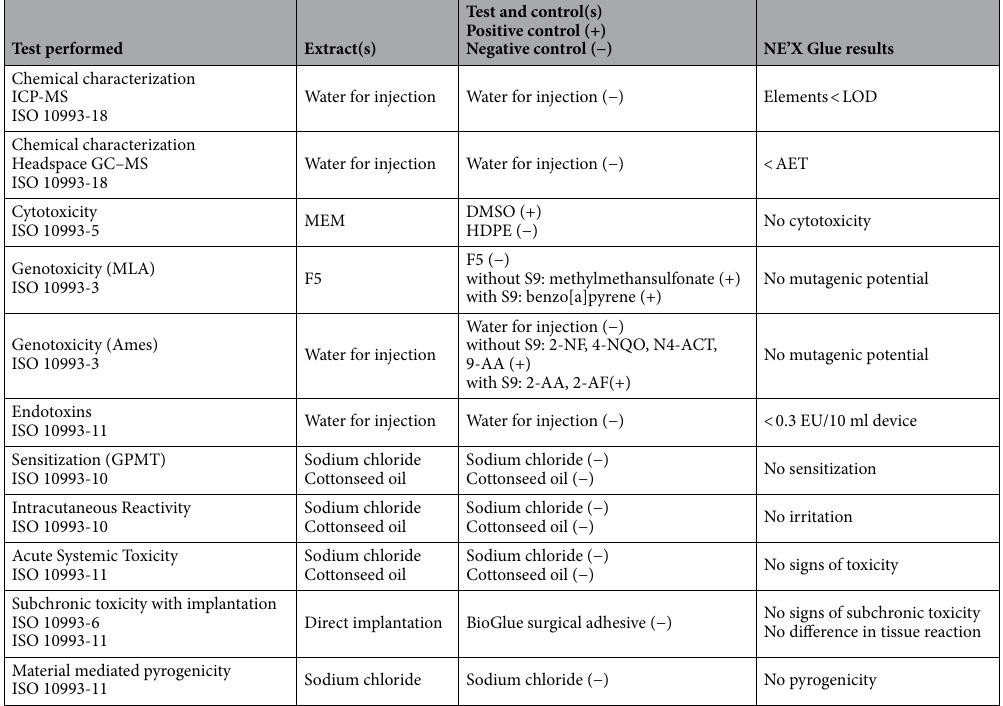
Table 15. NE’X Glue biocompatibility testing